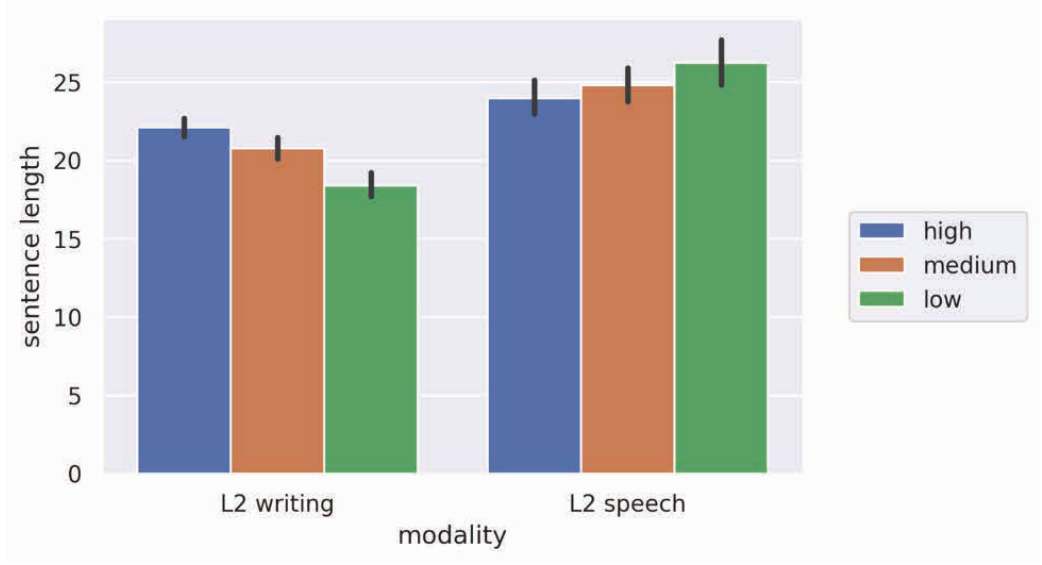
Fig ure 4: Sentence lengths across proficiency levels in L2 writing and speech As can be seen in Figure 2, the MDD of L2 writing appears to increase as the proficiency level advances from low to high, while an opposite trend is seen for speech. To test whether the differences were statistically significant, two ANOVA tests were performed on each of the modalities, with the DD as the dependent variable and the proficiency level as the independent variable. The omnibus test was significant for writing (F=27.06, p<0.0001), but not for speech (F=2.058, p>0.05). A post-hoc analysis was conducted to compare all paired means of proficiency levels in writing using Tukey Honest Significant Differences (TukeyHSD) with Bonferroni correction. Significant differences were found between all the pairs (p < 0.05). The results on writing confirm the findings of Jiang & Ouyang (2017), who reported that DD tends to increase with proficiency levels in L2 writing. However, these differences across the proficiency levels may again have been due to the differences in text length, which appeared to increase as proficiency level advances, as shown in Figure 3, and sentence length, which exhibited a trend similar to that of DD across the proficiency levels (shown in Figure 4). Tab le 4: Hierarchical multiple regression analyses of the effects of proficiency on DD in writing